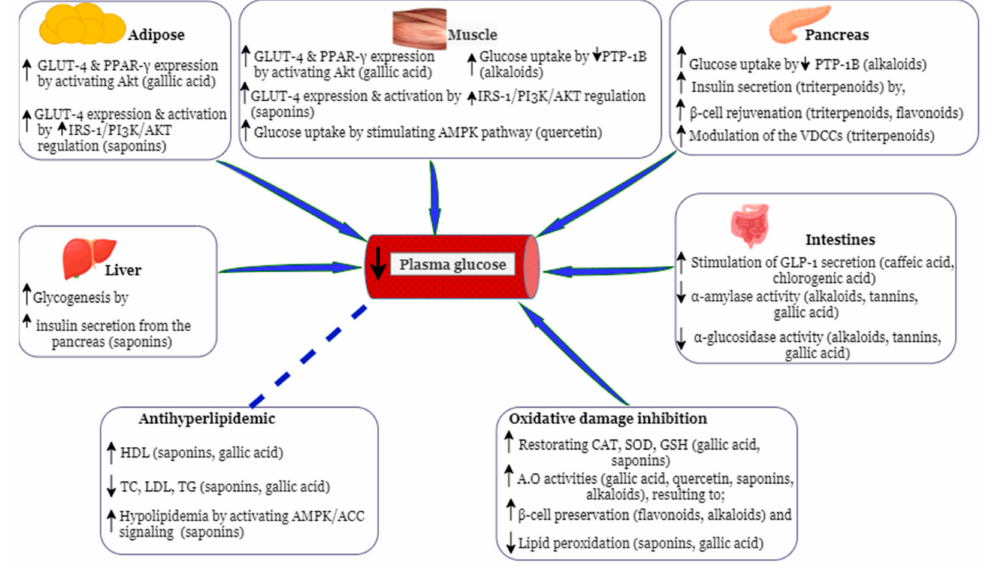
Figure 3. Potential mechanisms of action by Solanum anguivi Lam. Fruit phytochemicals in their antidiabetic effects. PPAR = peroxisome proliferator-activated receptors, GLUT = glucose transporter, IRS = insulin receptor substrate, AMPK = adenosine monophosphate-activated kinase, ACC = acetyl- CoA carboxylase, PI3-K = phosphatidylinositol-3-kinase, VDCCs = voltage-dependent calcium channels, GLP = glucagon-like peptide, PTP-1B = protein tyrosine phosphatase-1B, CAT = catalase, SOD = superoxide dismutase, GSH = glutathione, A.O = antioxidant, upward black arrows = in- creased, downward black arrows = inhibition of, blue arrows = mechanisms of action resulting in reduced plasma glucose levels, stripped blue line = relationship between hypoglycemia and hypolipi- demia. The figure was drawn via https://app.diagrams.net/, and the pancreas, liver, muscle, and intestine pictures were obtained from